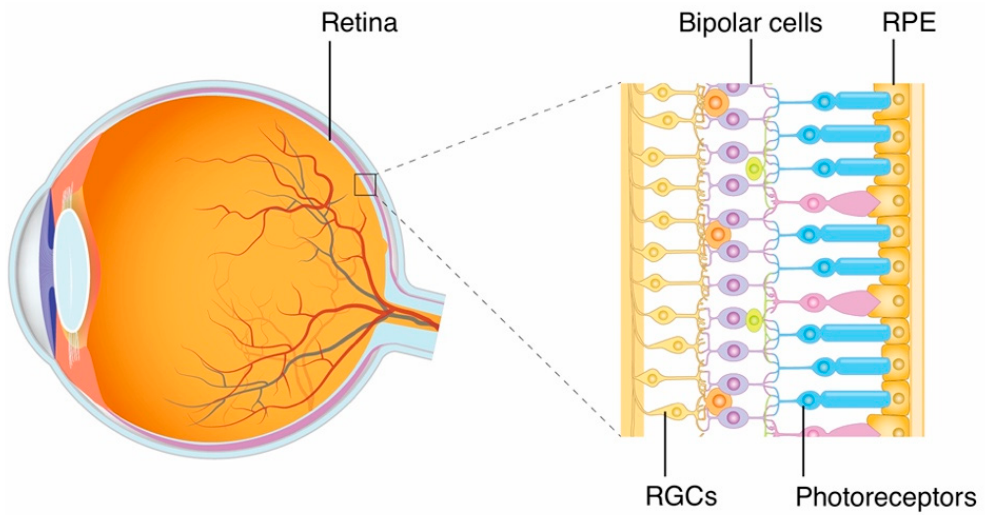
Figure 1. The retina is a layered structure lining the back of the eyeball. The visual pathway in the retina consists of three neurons: photoreceptors, bipolar cells, and retinal ganglion cells (RGCs). The retinal pigment epithelium (RPE) maintains retinal function.